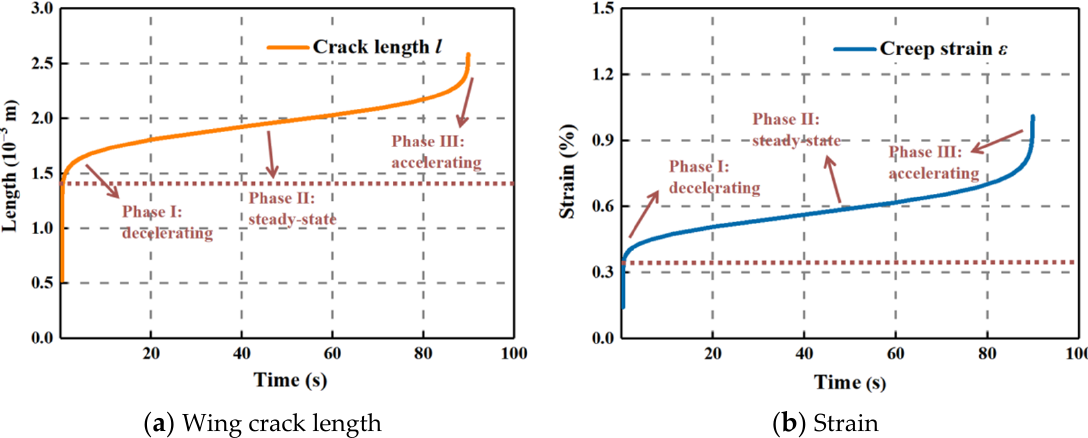
Figure 6. Time-dependent evolution of the microcracks’ length ( a ) and strain ( b ) at 114 MPa.